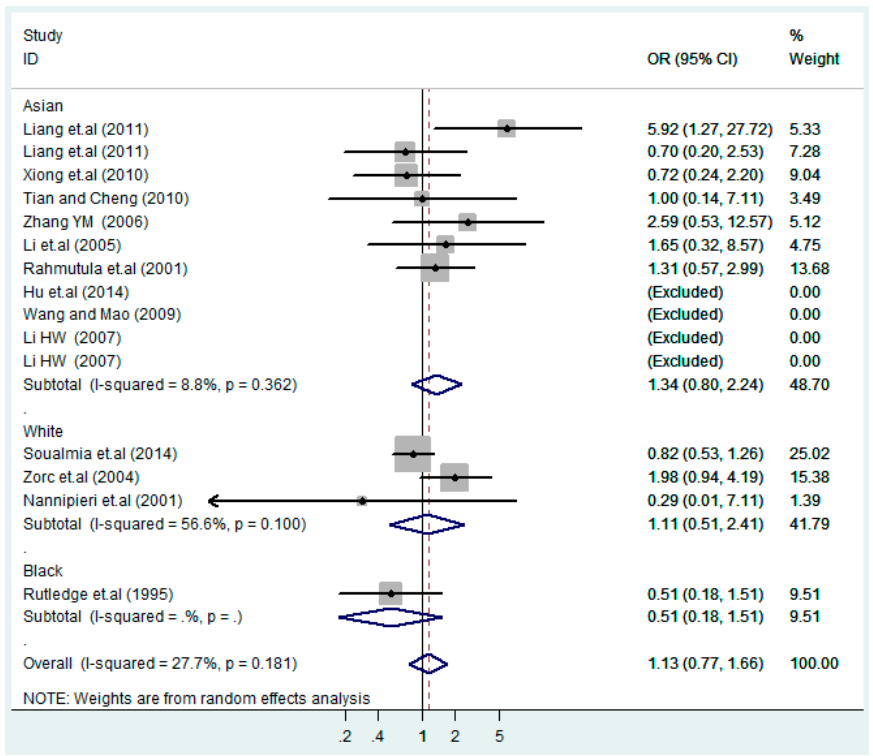
Figure 12. Ethnic subgroup analysis of T2238C dominant model (CC + TC) vs. TT.